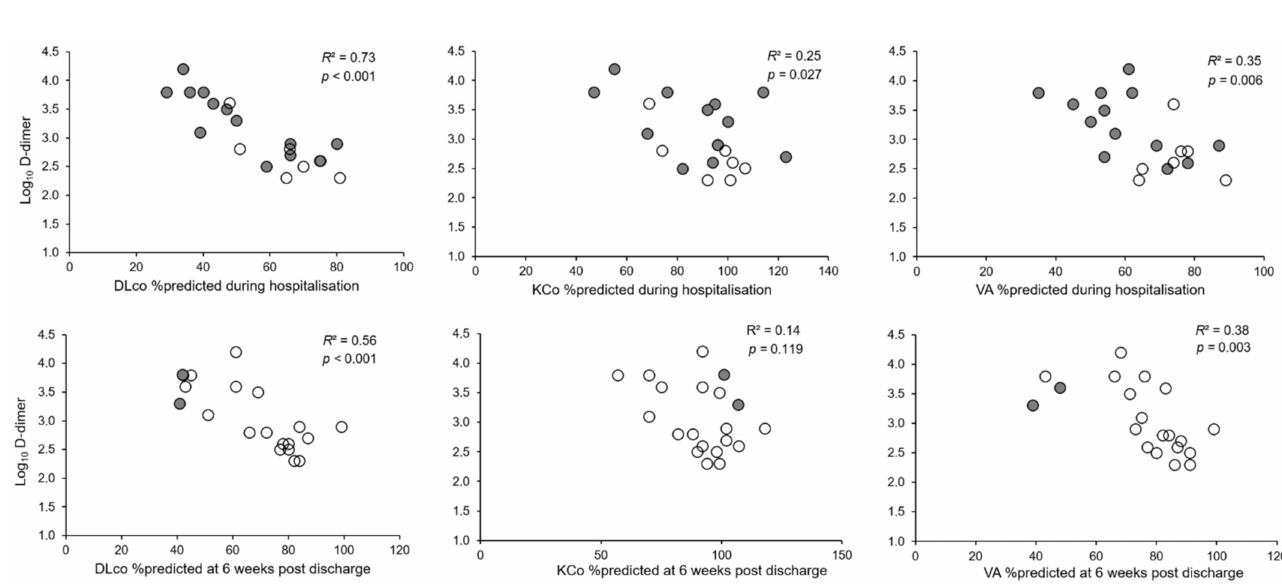
Figure 6. Relationship between D-dimer values at admission and DLco, KCO, and VA % predicted at first assessment during hospitalisation (upper panels) and after 6 weeks from hospital discharge (lower panels). Full circles are patients with consolidations at the chest CT perfromed the same day of the DLco, and empty circles indicate patients with- out consolidations. DLco = lung diffusion capacity for carbon monoxide; KCO = transfer factor for carbon monoxide; VA = alveolar